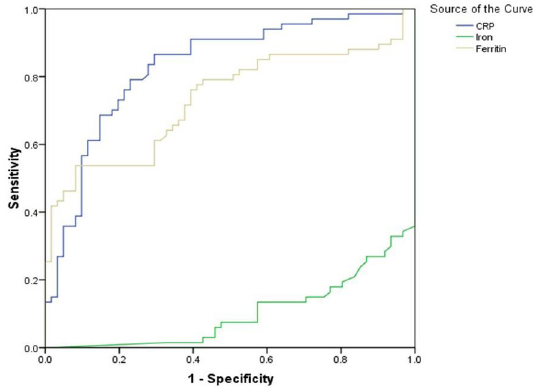
Figure 3. Area under the ROC curve to assess the value of CRP, ferritin and low iron to discriminate TCC infection from noninfectious statement.